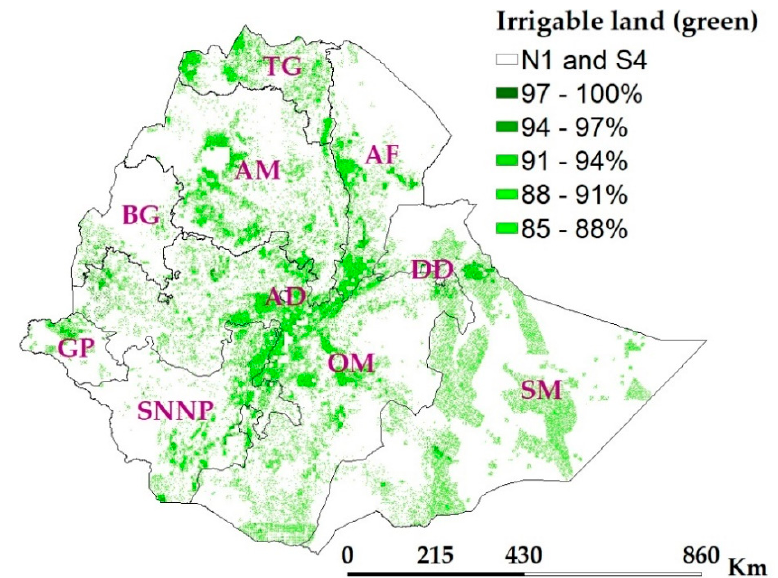
Figure 4. Potentially irrigable land (all green, weight ≥ 85); S4 (currently unsuitable areas)- weight < 85%; N1—constraint (permanently unsuitable areas); abbreviations in the map are administrative regions (TG—Tigray, AM—Amhara, AF—Afar, BG—Benshangul Gumaz, AD—Addis Ababa, DD—Dire Dawa, GP—Gambela Peoples, SNNP—Southern Nations, Nationalities and Peoples, and SM— Somali).